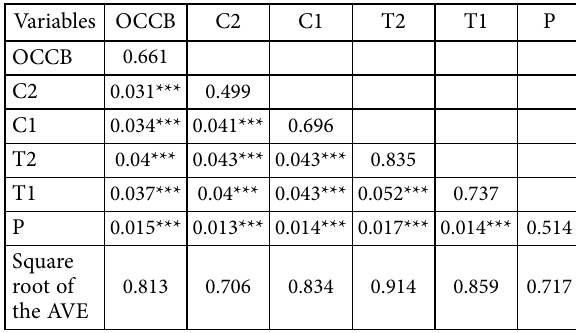
Table 6. Discriminant validity